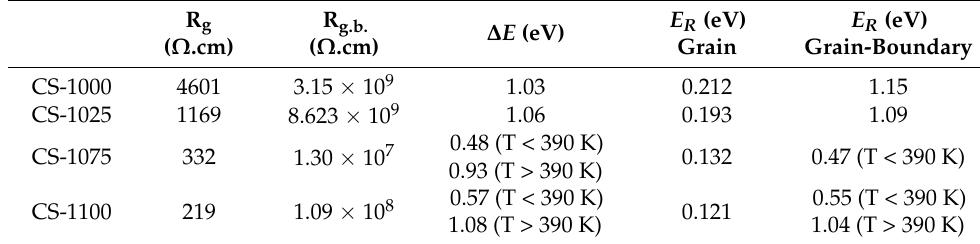
Table 2. The resistivity of grain (R g ), grain-boundary (R g.b. ), activation energy for conduction ( ∆ E), and for relaxation process (E R ) in NSCTO